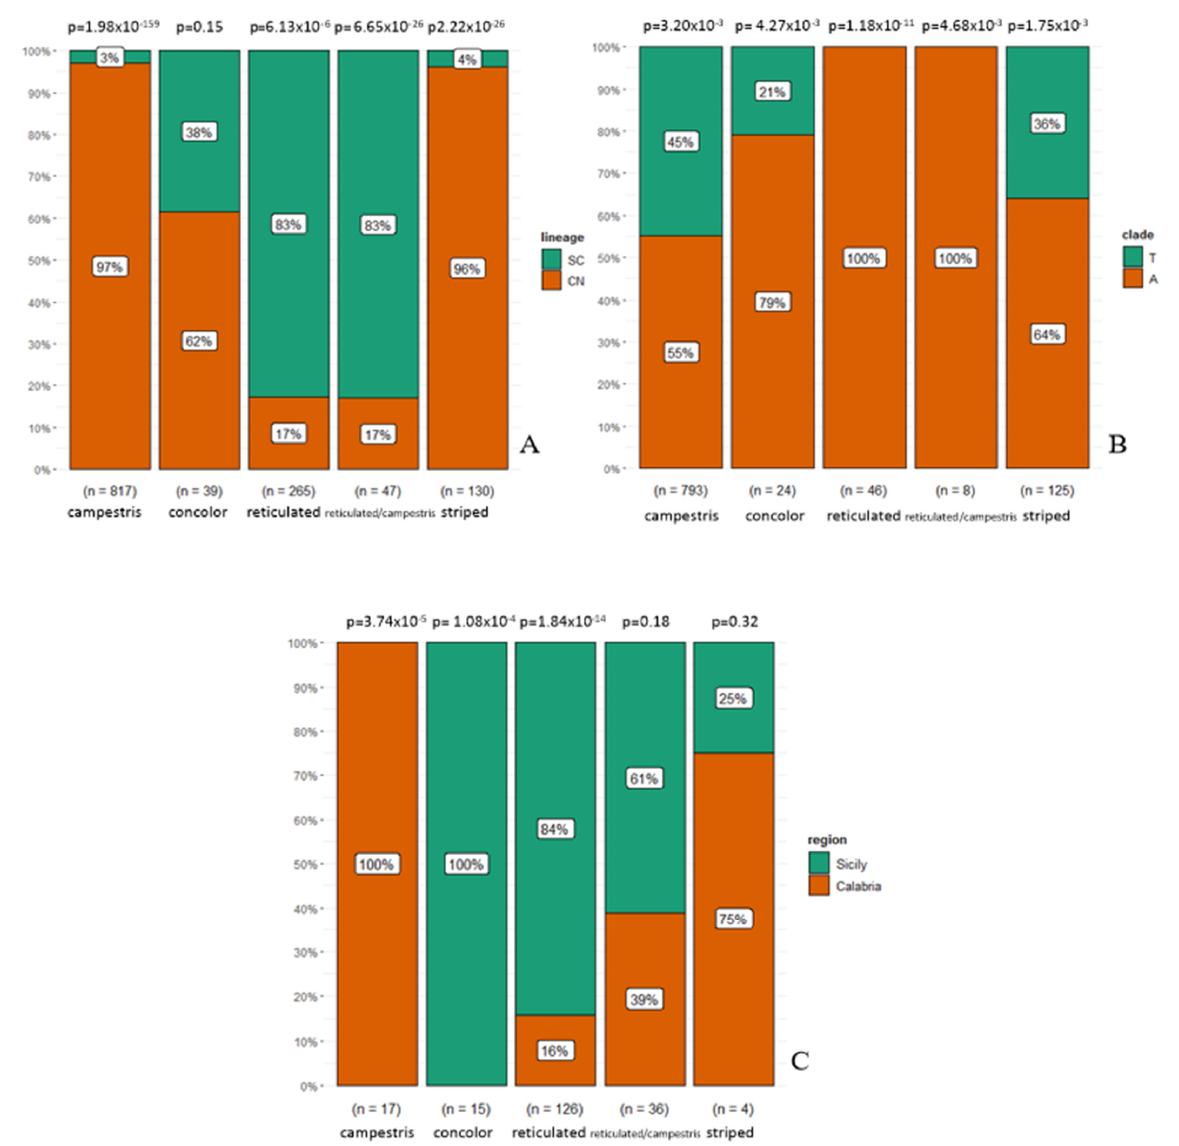
Figure 4. χ 2 test results. Bar charts indicate the percentage of association of each phenotype with lineages ( A ), clades ( B ) or regions ( C ). lineages ( A ), clades ( B ) or regions ( C